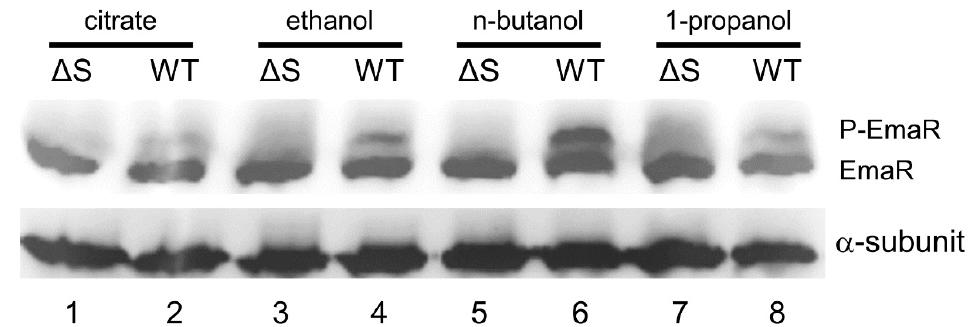
Figure 3. Phos-tag TM analysis of P-EmaR. A. baumannii wild-type and ∆ S mutant strains were cultured in M9 medium containing 5 mM citrate (lane 1, 2), 5 mM citrate with 0.5% ethanol (lane 3, 4), 5 mM citrate with 0.5% n-butanol (lane 5, 6), or 5 mM citrate with 0.5% 1-propanol. The anti- α subunit was used as an internal control.